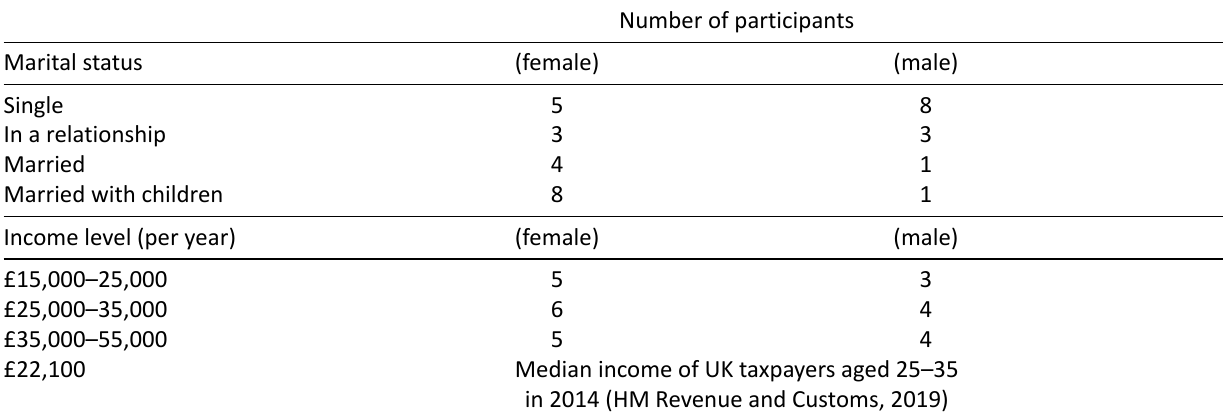
Table 1. Marital status and income level of participants.